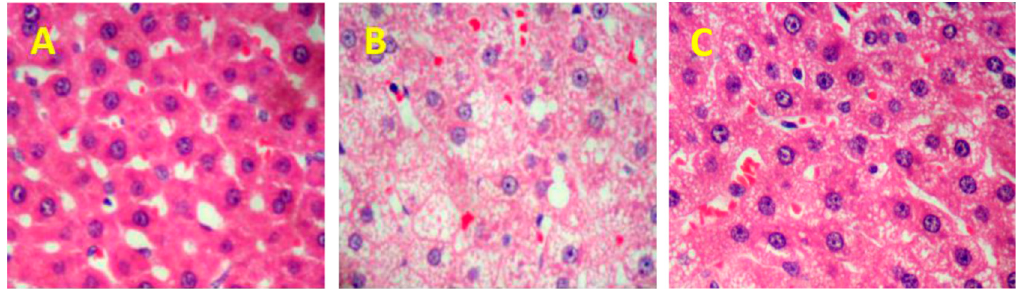
Figure 2. Histopathological analysis of rat hepatic tissues in the different groups at 40× magnification. ( A ) NFD group; ( B ) HFD group; ( C ) SPL95 group.